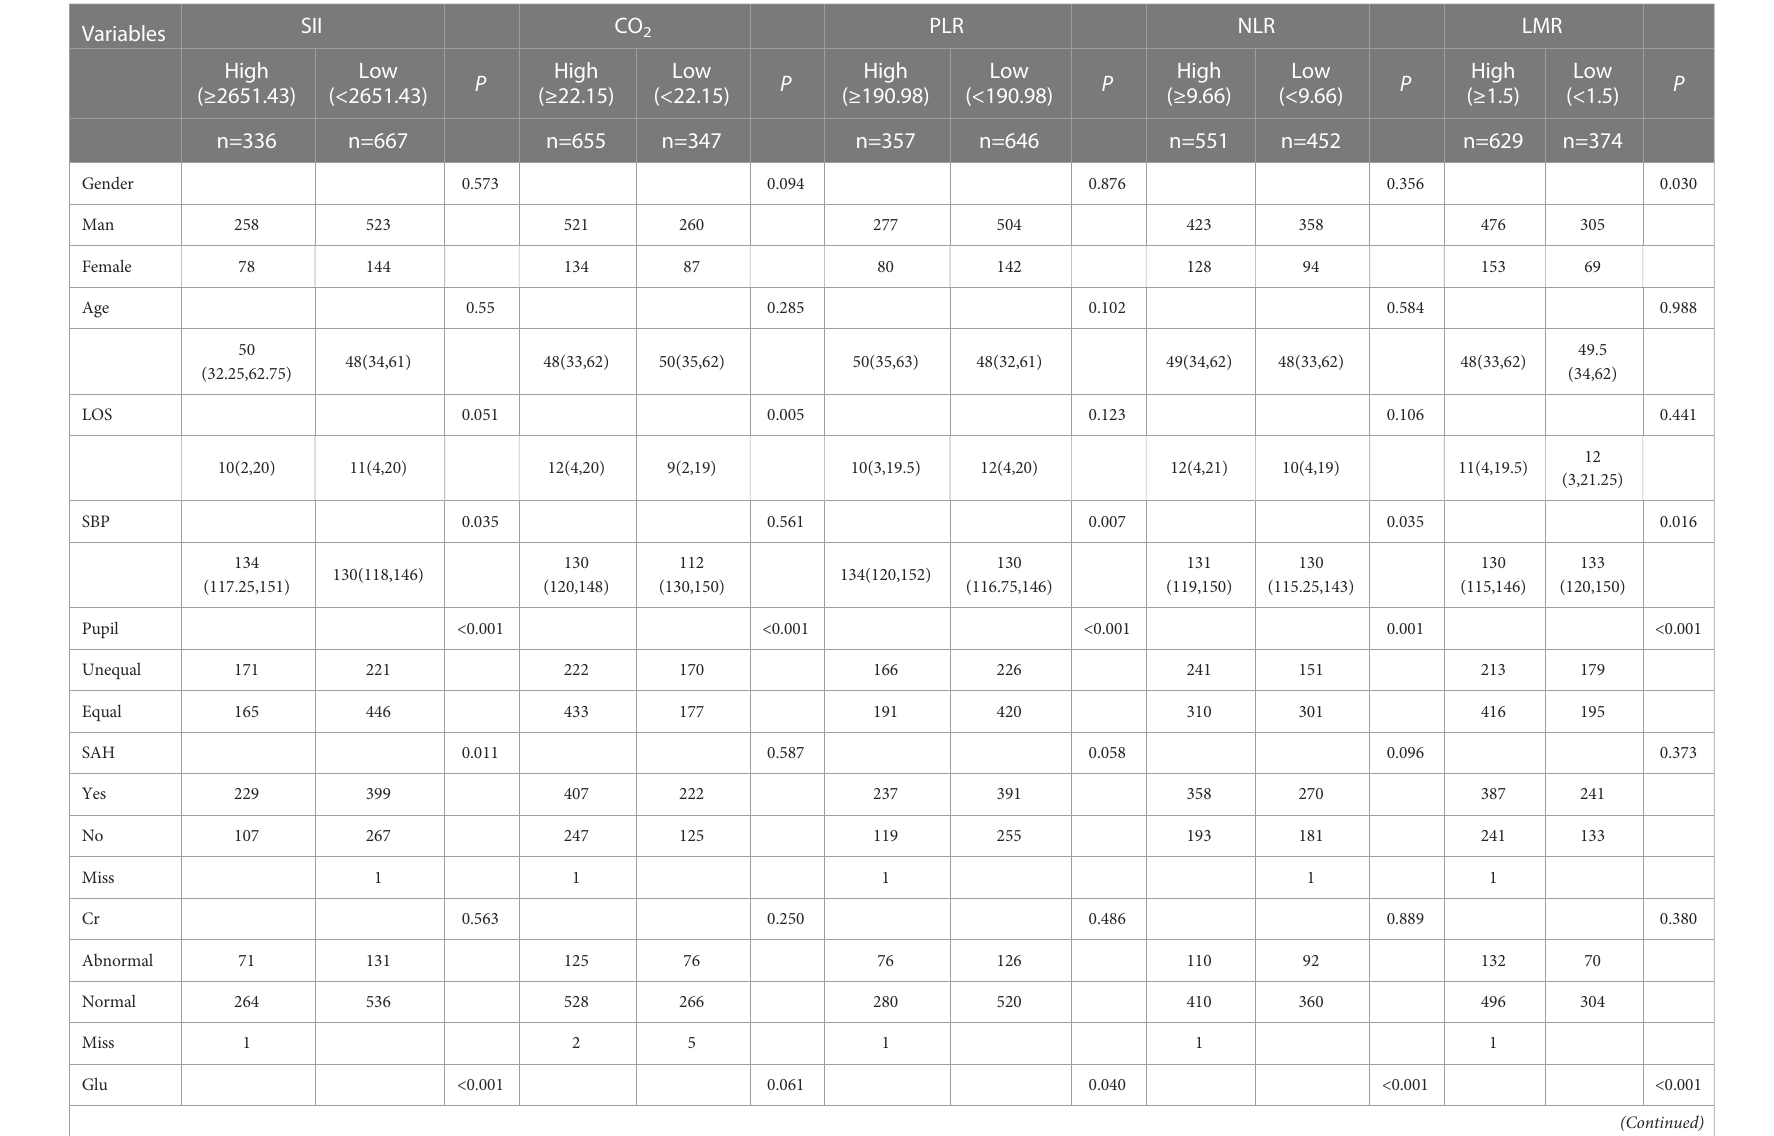
TABLE 1 Relationships among SII, CO 2 , PLR, NLR, and LMR, and basic clinical features in patients with severe TBI.